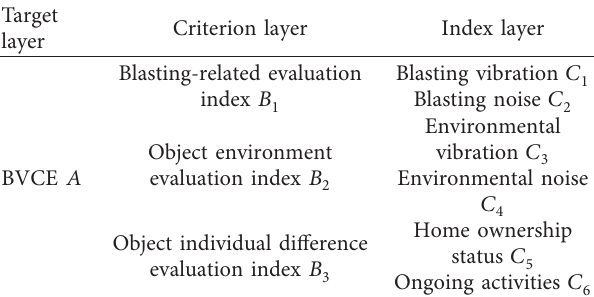
Table 1: The index system of